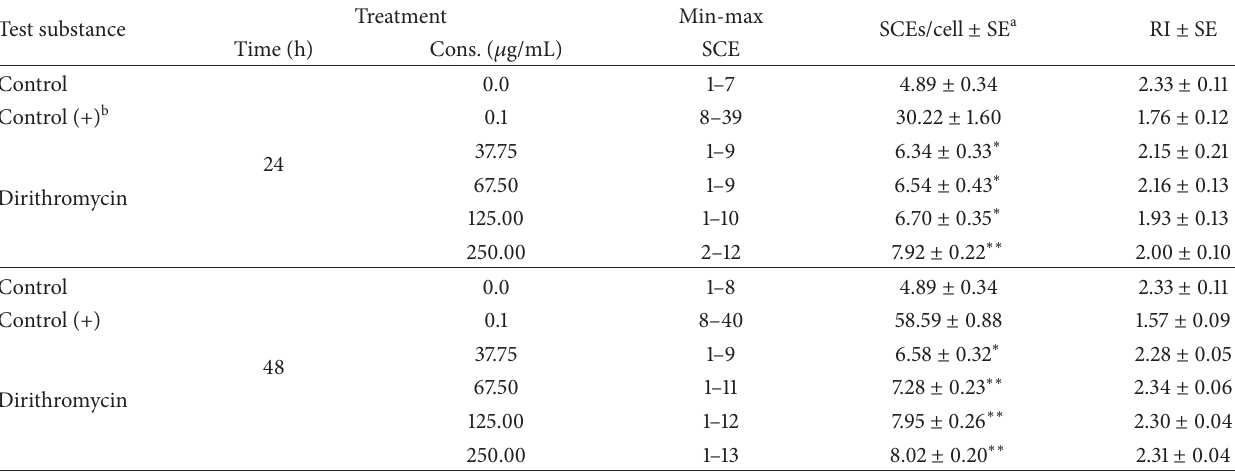
Table 1: Frequency of sister chromatid exchanges (SCEs/cell) and replication index (RI) in cultured human lymphocytes treated with dirith- romycin and controls.